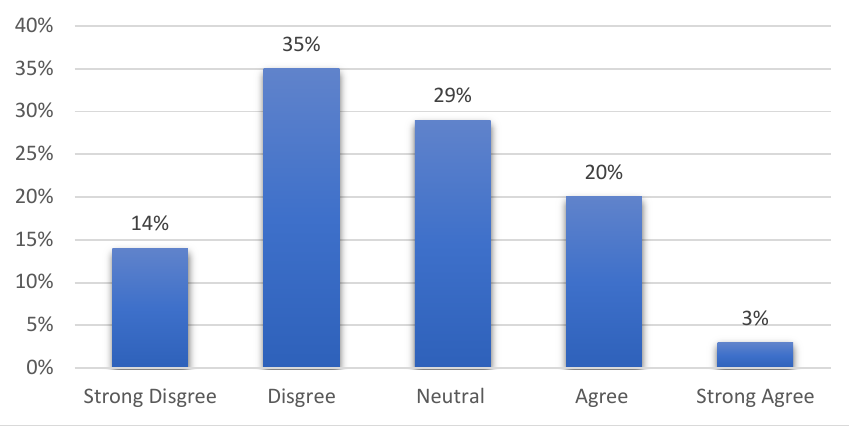
Figure 4: Improvement of services